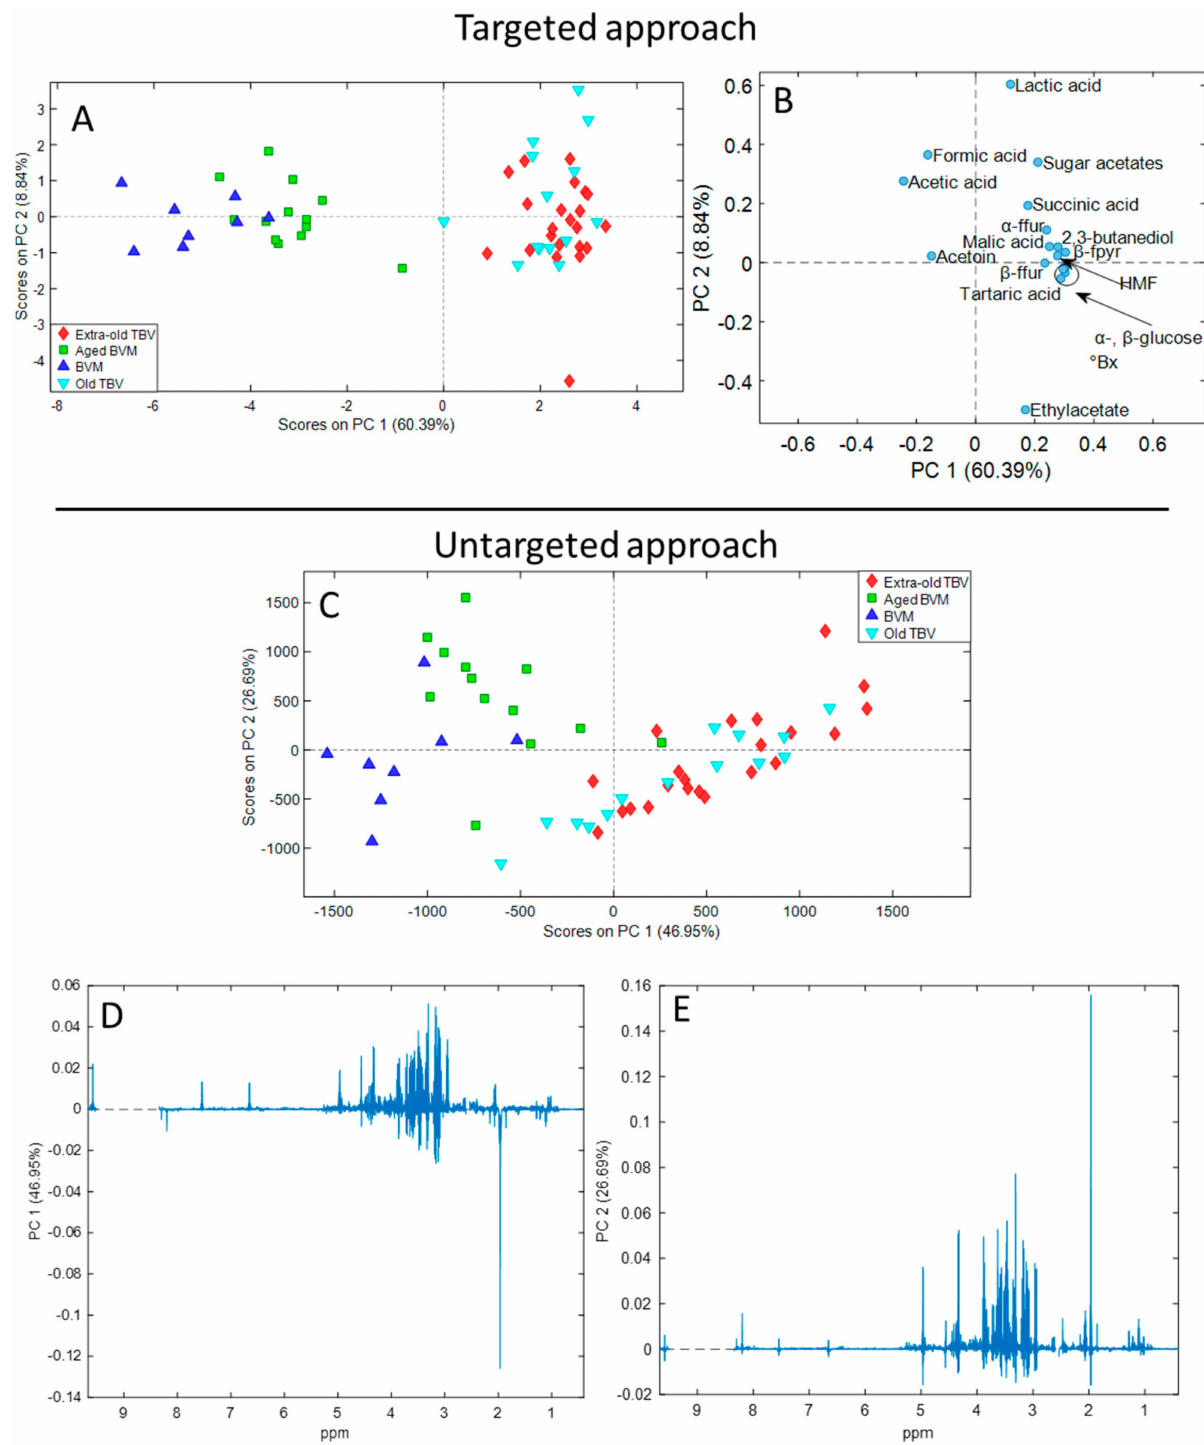
Figure 2. Score ( A , C ) and loading ( B , D , E ) plots of the principal component analyses performed on targeted (quantitative results from qNMR analysis) and untargeted (spectral points of NMR spectra)